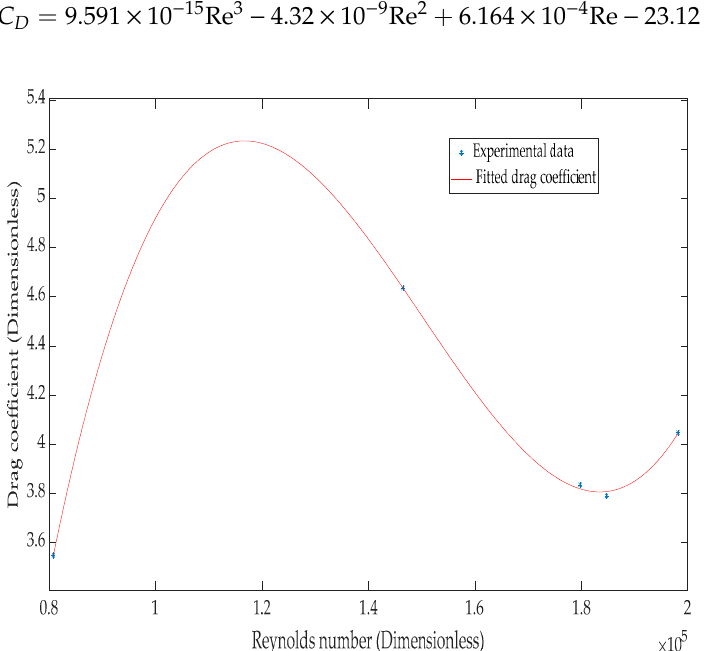
Figure 13. Drag coefficient as a function of the Reynolds number. Figure 13. Drag coe ffi cient as a function of the Reynolds